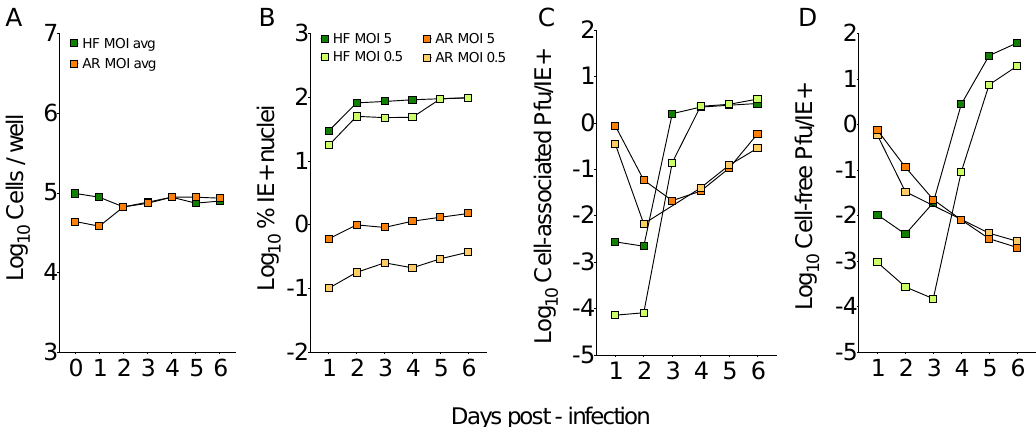
Figure 1. TB40 / E stock tropism for fibroblasts and epithelial cells. Human foreskin fibroblasts (HFF) and ARPE-19 cells were exposed to TB40 / E stock 31915 at a multiplicity of infection (MOI) of 0.5 or 5 pfu / cell. At each time post-infection, cells and supernatants were collected and used to determine the total number of cells / well ( A ), the proportion of cells expressing the nuclear IE1 / IE2 proteins ( B ), the amounts of cell-associated progeny per IE + nucleus ( C ) and the amounts of cell-free progeny per IE + nucleus ( D ). All titrations were conducted on HFF.